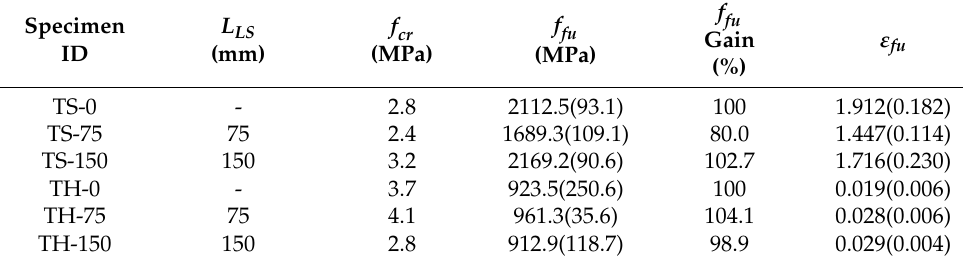
Figure 4. Test setup, instrumentation, and failure mode: ( a ) TS-0 specimen; ( b ) TH-0 specimen. Table 4. The results for direct tension tests (average values of three tests).